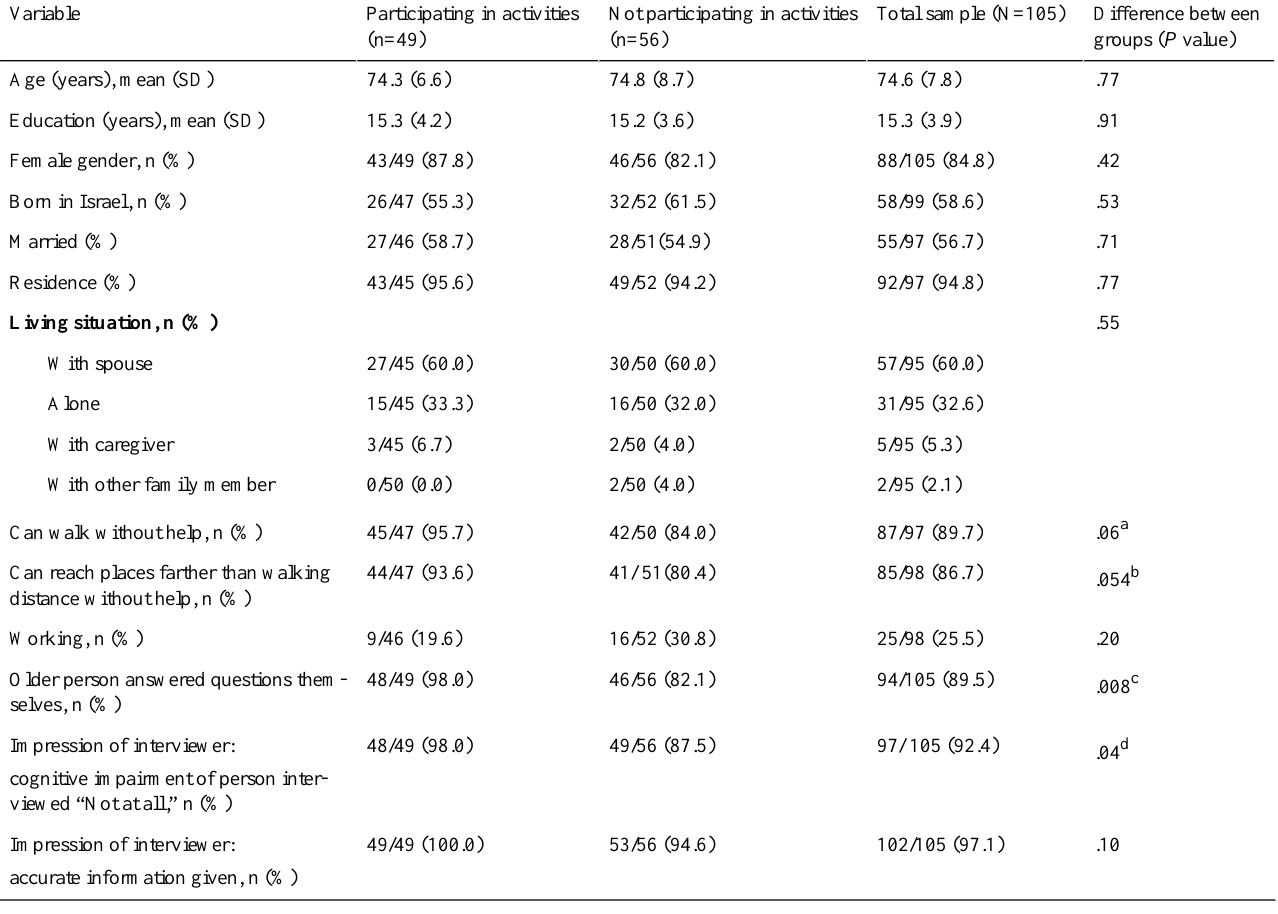
Table 1. Background variables of the study participants (N=105).